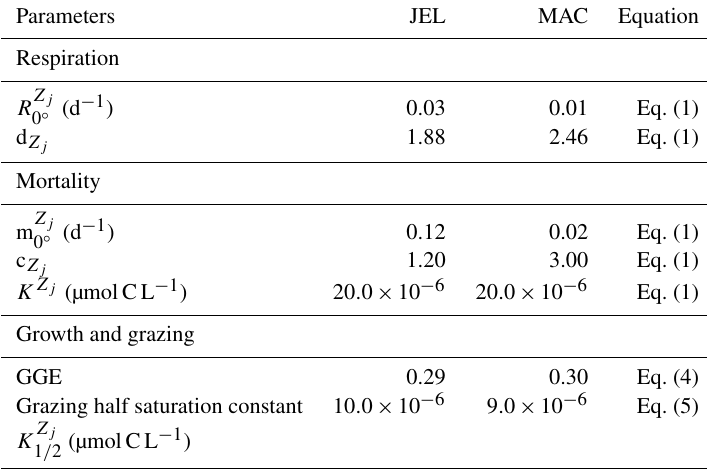
Table 4. PlankTOM11 parameter values for macrozooplankton and jellyfish, with the associated